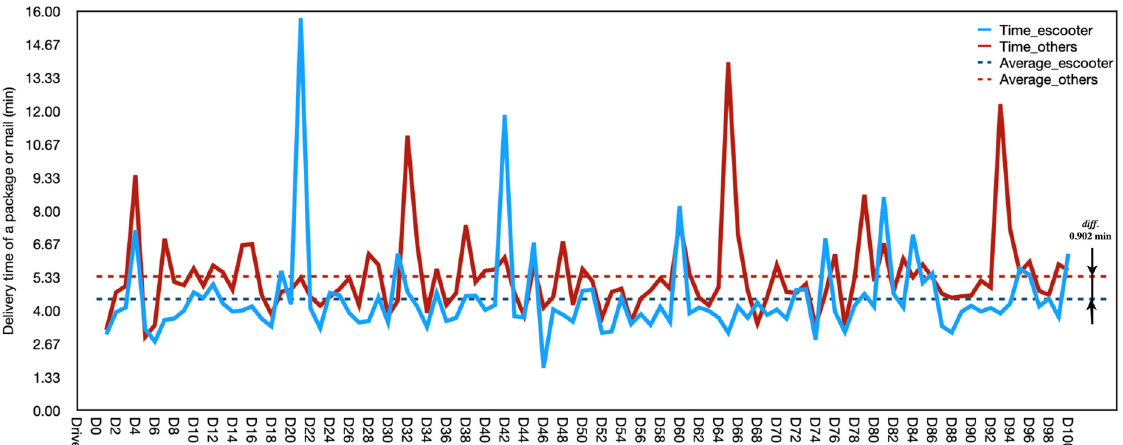
Figure 9. The delivery time of a package or mail on behalf of delivery vehicles.